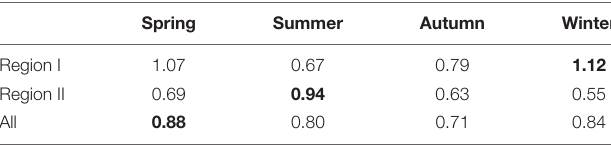
larger jump, increasing by 1.72 and 1.40 mm decade − 1 in winter and summer, respectively, significant at the 10% level.